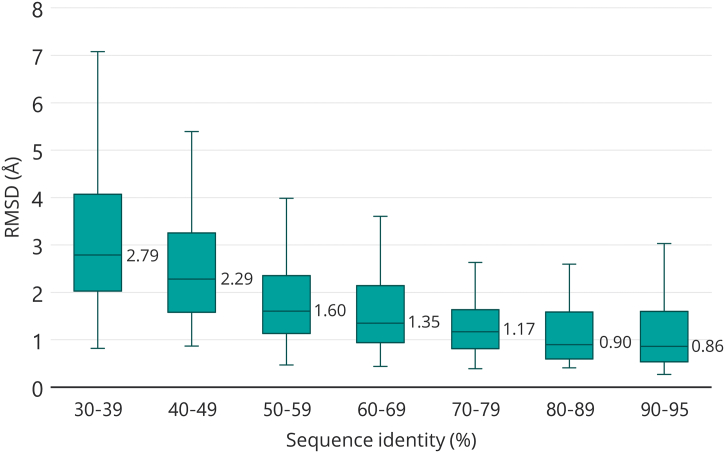
The distribution of the RMSD (Å) between the Phyre2-predicted models and the true experimental coordinates binned according to the % sequence identity between query and template. The central line in a box is the median RMSD with its value reported. The upper and lower box boundaries are the upper and lower quartiles. The whiskers extend up an additional 1.5 × the difference between the median and the upper quartile and down an additional 1.5 × the difference between the median and the lower quartile.